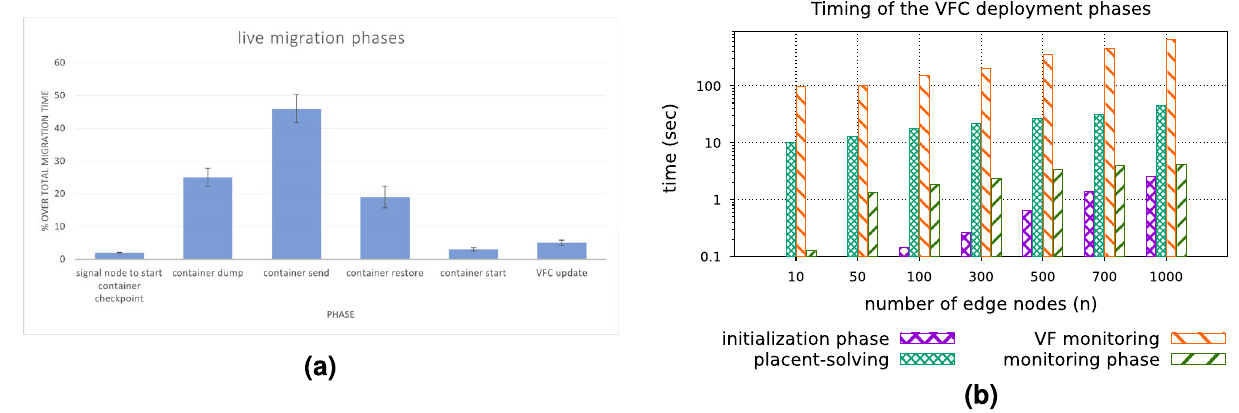
Figure 9. Timing of the live migration phases ( a )and Timing of the different VFC phases ( b ).